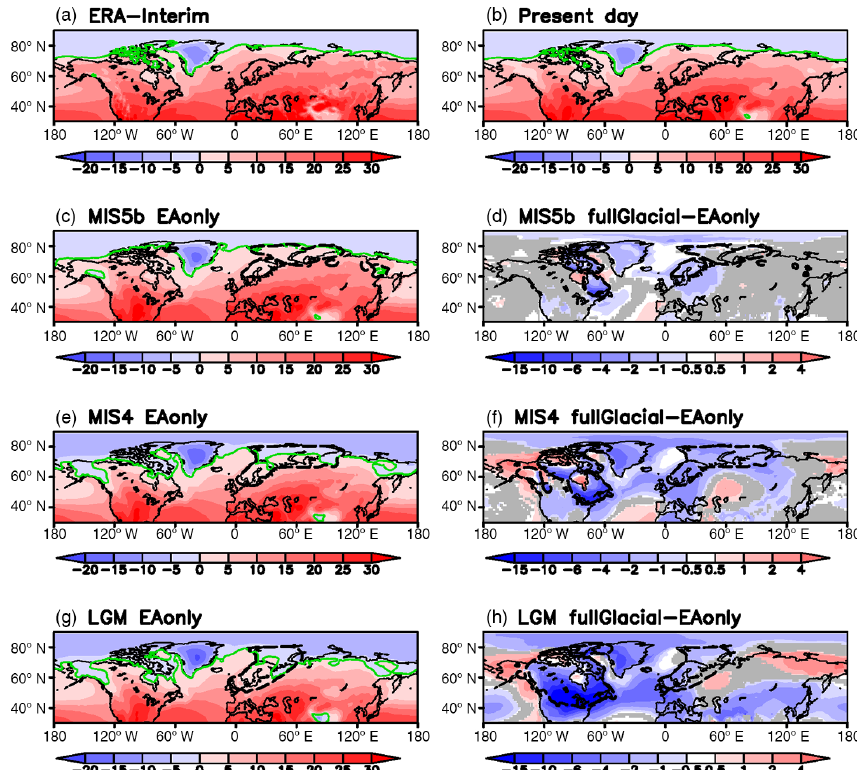
Figure 4. Boreal summer (JJA) surface temperature (in ◦ C) from (a) the ERA-Interim climatology (Dee et al., 2011), (b) the present-day simulation, and the EAonly simulations (with PI OHT) of (c) MIS5b, (e) MIS4, and (g) LGM; green contour denotes the zero-degree surface isotherm. Panels (d, f, h) show the JJA surface temperature anomalies induced by the North American ice sheet (the difference between the fullGlacial and EAonly simulations; in ◦ C) for (d) MIS5b, (f) MIS4, and (h) LGM. The temperature in the glacial simulations (c) to (h) has been projected to the present-day orography using the standard lapse rate ( γ = − 6 . 5 × 10 − 3 Km − 1 ). The dashed black contours depict the outlines of the Kleman et al. (2013) ice-sheet reconstructions in Eurasia and North America. Only significant changes at 95% (based on Student’s t test) are shown in (d, f, h) (nonsignificant changes are displayed in